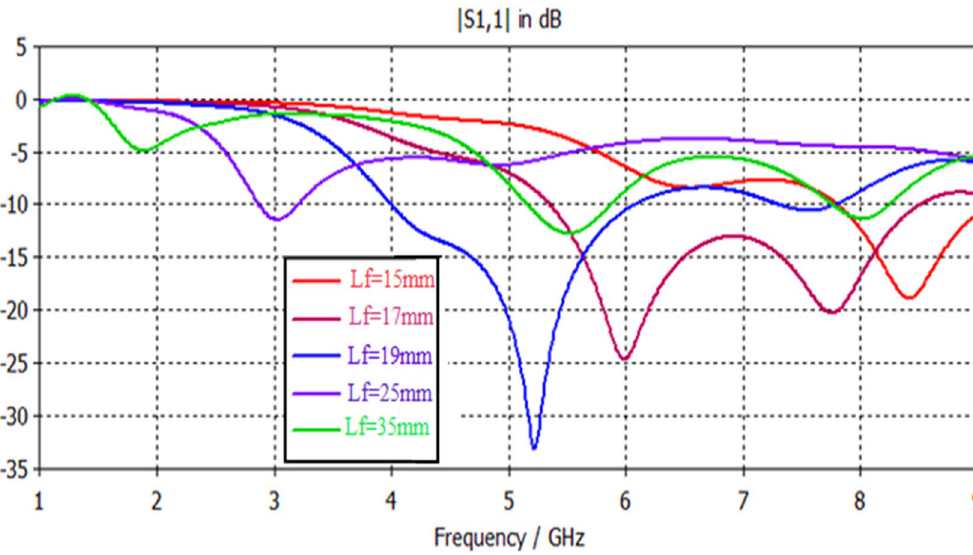
Figure 19. S11 responses of the antenna structure depicted in Fig. 3 with feedline length as a parameter.